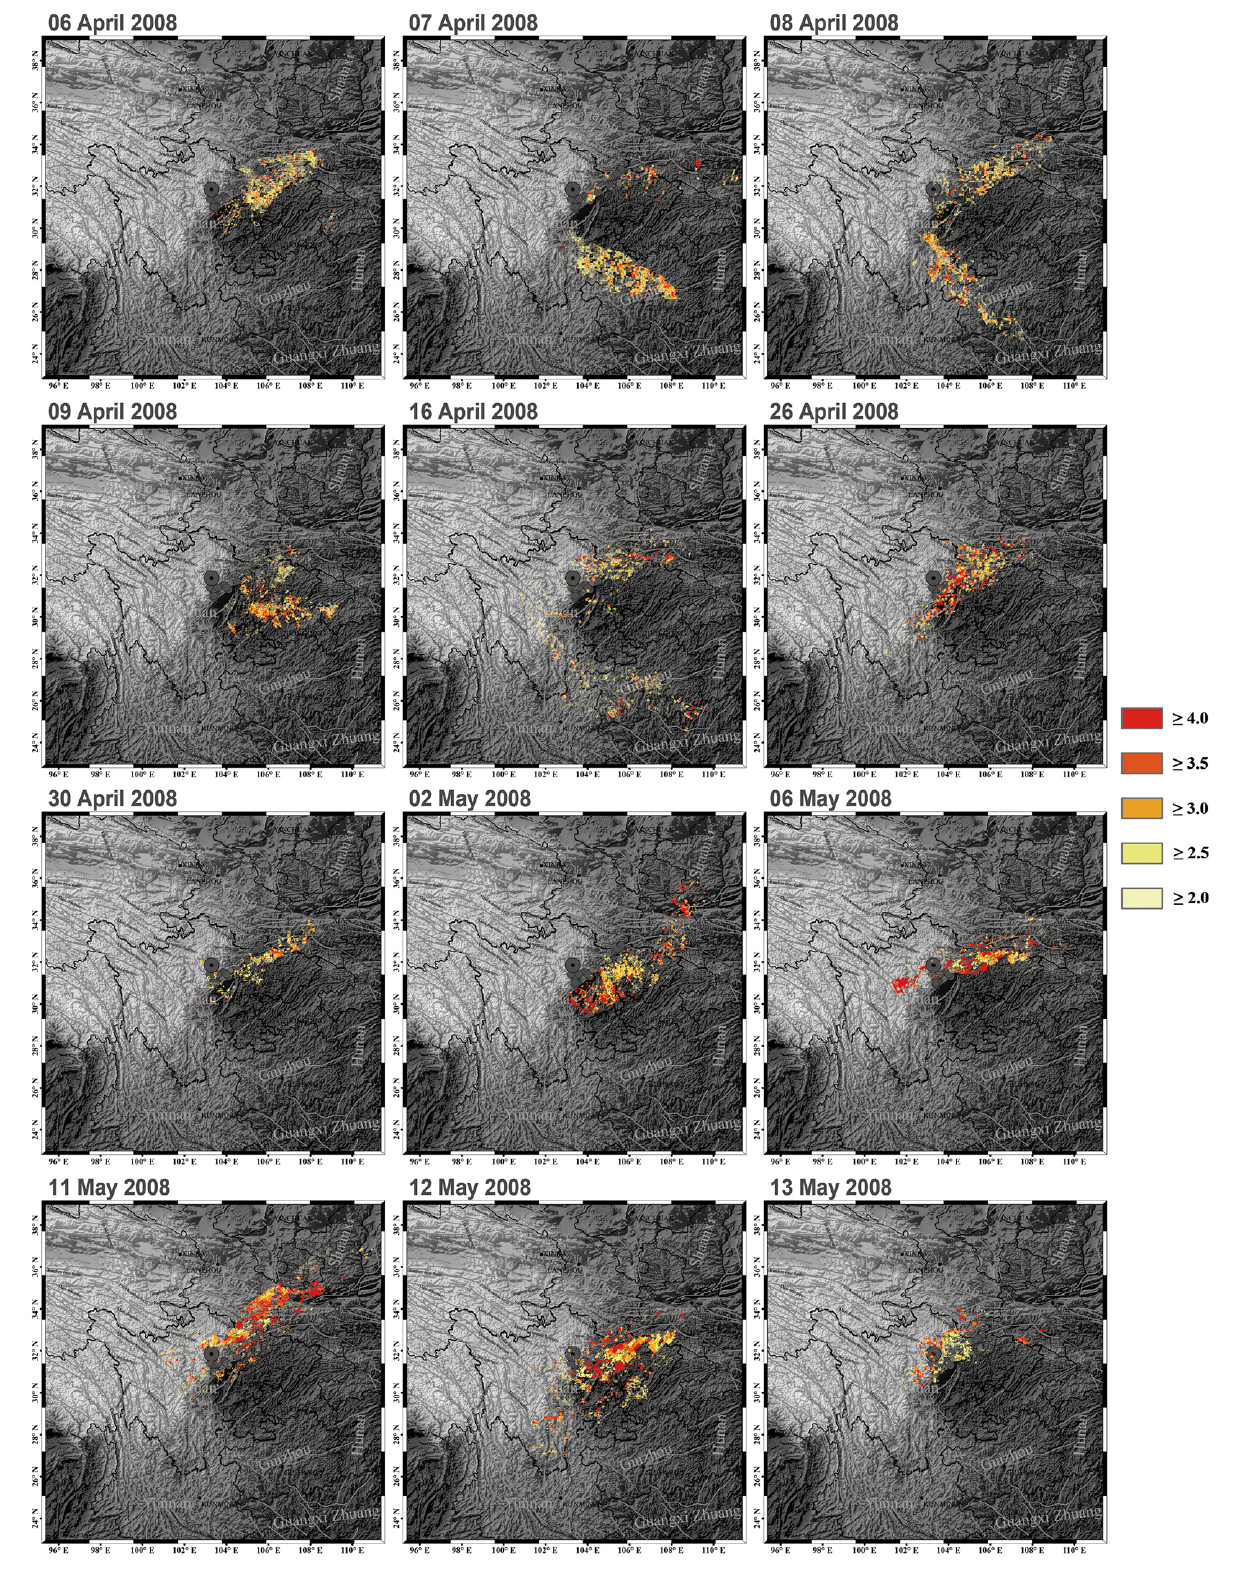
Figure 3. Results of the RETIRA index computed on the investigated area before and after the Wenchuan earthquake using AATSR BT data(Nadir view) from April 6, 2008, to May 13,